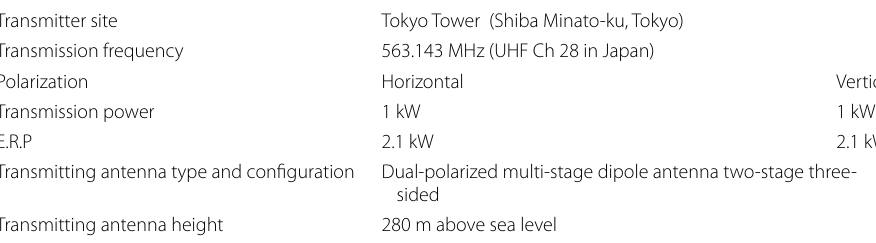
Table 2 Specifications of experimental test station